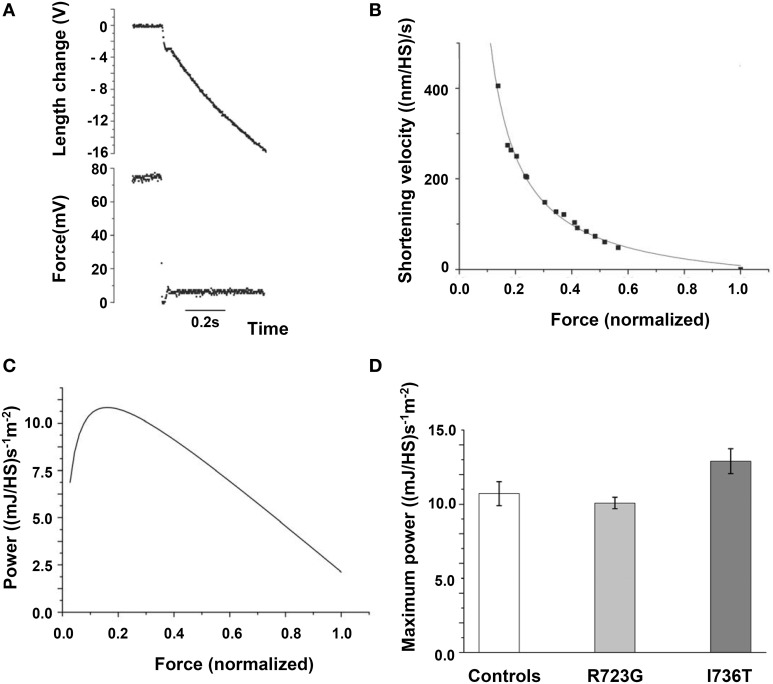
Force-velocity relation and maximum power output. (A) Original length and force traces of a quick release experiment in which the fiber was switched from isometric steady state to isotonic shortening. Load during isotonic shortening about 10% of isometric force. Note the curved time course of fiber length similar to the time course of unloaded shortening by the slack test experiment (Figure 5, top panel). Initial shortening velocity determined according to Brenner (1986). (B) Force-velocity relation constructed by plotting initial shortening velocity vs. applied load, i.e., force exerted by fiber during shortening. Solid line is fit of Hill equation (Hill, 1938) to data points. (C) Power at different loads, solid line derived from Hill equation fitted to data points, i.e., solid line in (B). (D) Effect of mutations R723G and I736T on maximum power; mean ± SE, n = 12 − 14 fibers. Differences not statistically significant (p > 0.05). T = 20°C.